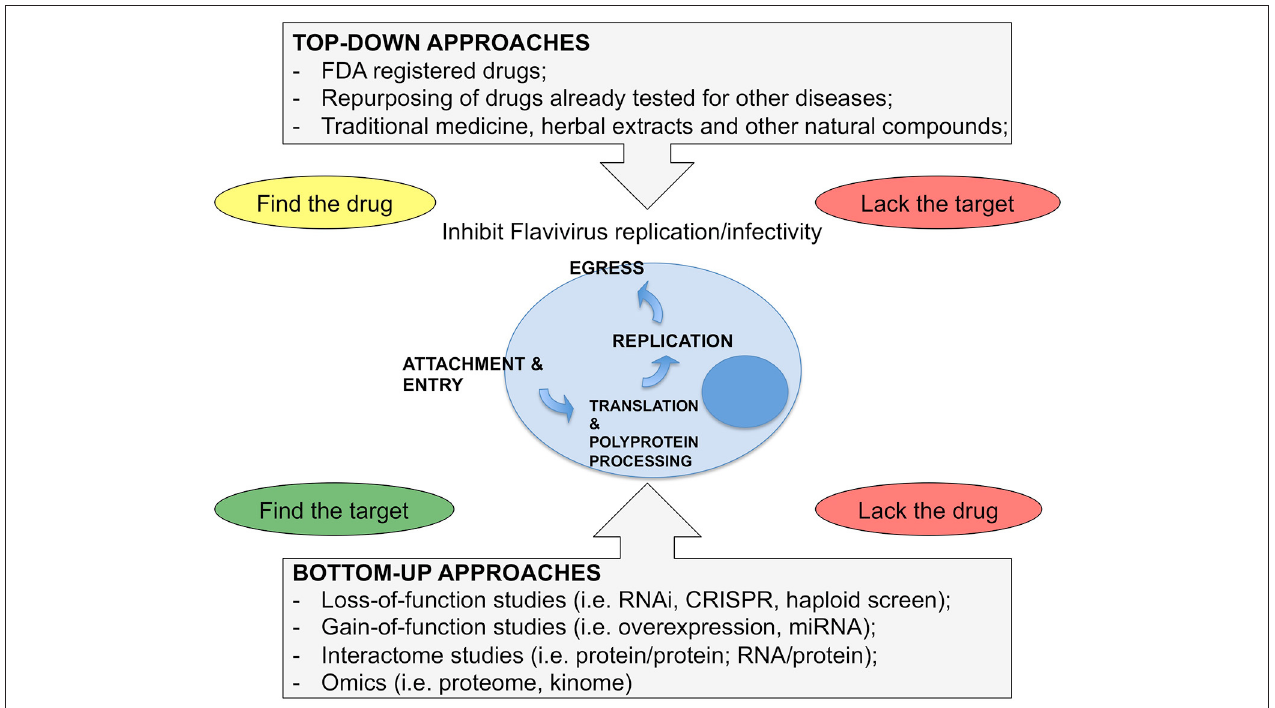
FIGURE 1 | Strategies for antiviral HDT. (Top-Down) approaches consider drugs from various sources as starting material for a screen of antiviral activity. These approaches can identify drugs with both viral and cellular targets. However, when starting from complex mixtures, it is not easy to define the active compound, while screenings of Food and Drug Administration (FDA) registered drugs have the advantage of knowing the drug in advance and, in most cases, the target. Bottom-up approaches are based on unbiased screens by depleting or overexpressing host factors or miRNAs. Here the critical issue is to find the drug for the target that is identified by the screen. (Bottom-Up) approaches also include various approaches where the network of virus-host interactions is studied or where the response of the cell to the infection is analyzed as a whole. These methods require functional validation and only after that it is possible to proceed further and select the